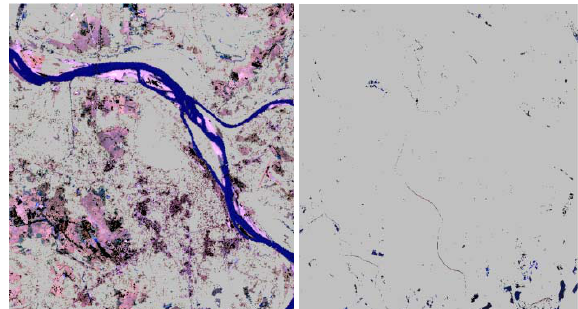
Figure 4. Modulation 022222 for Landsat 5 TM (left) and Spot 5 (right)